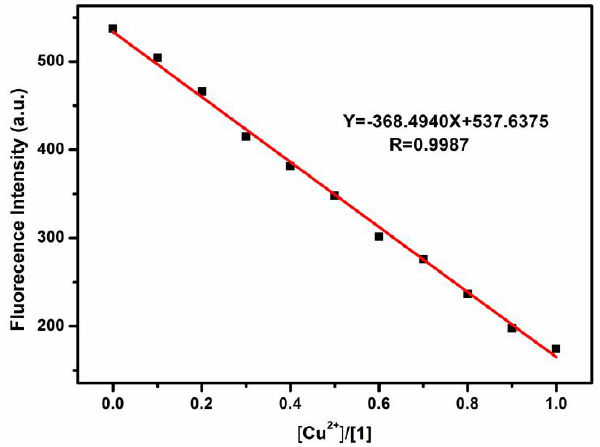
Figure 4. Fluorescence intensity measured at 387 nm for Probe 1 in ethanol (10 μM) as a function of the concentration of Cu 2+ (0–1 equiv.). Inset shows the linear fitting result of the data points.